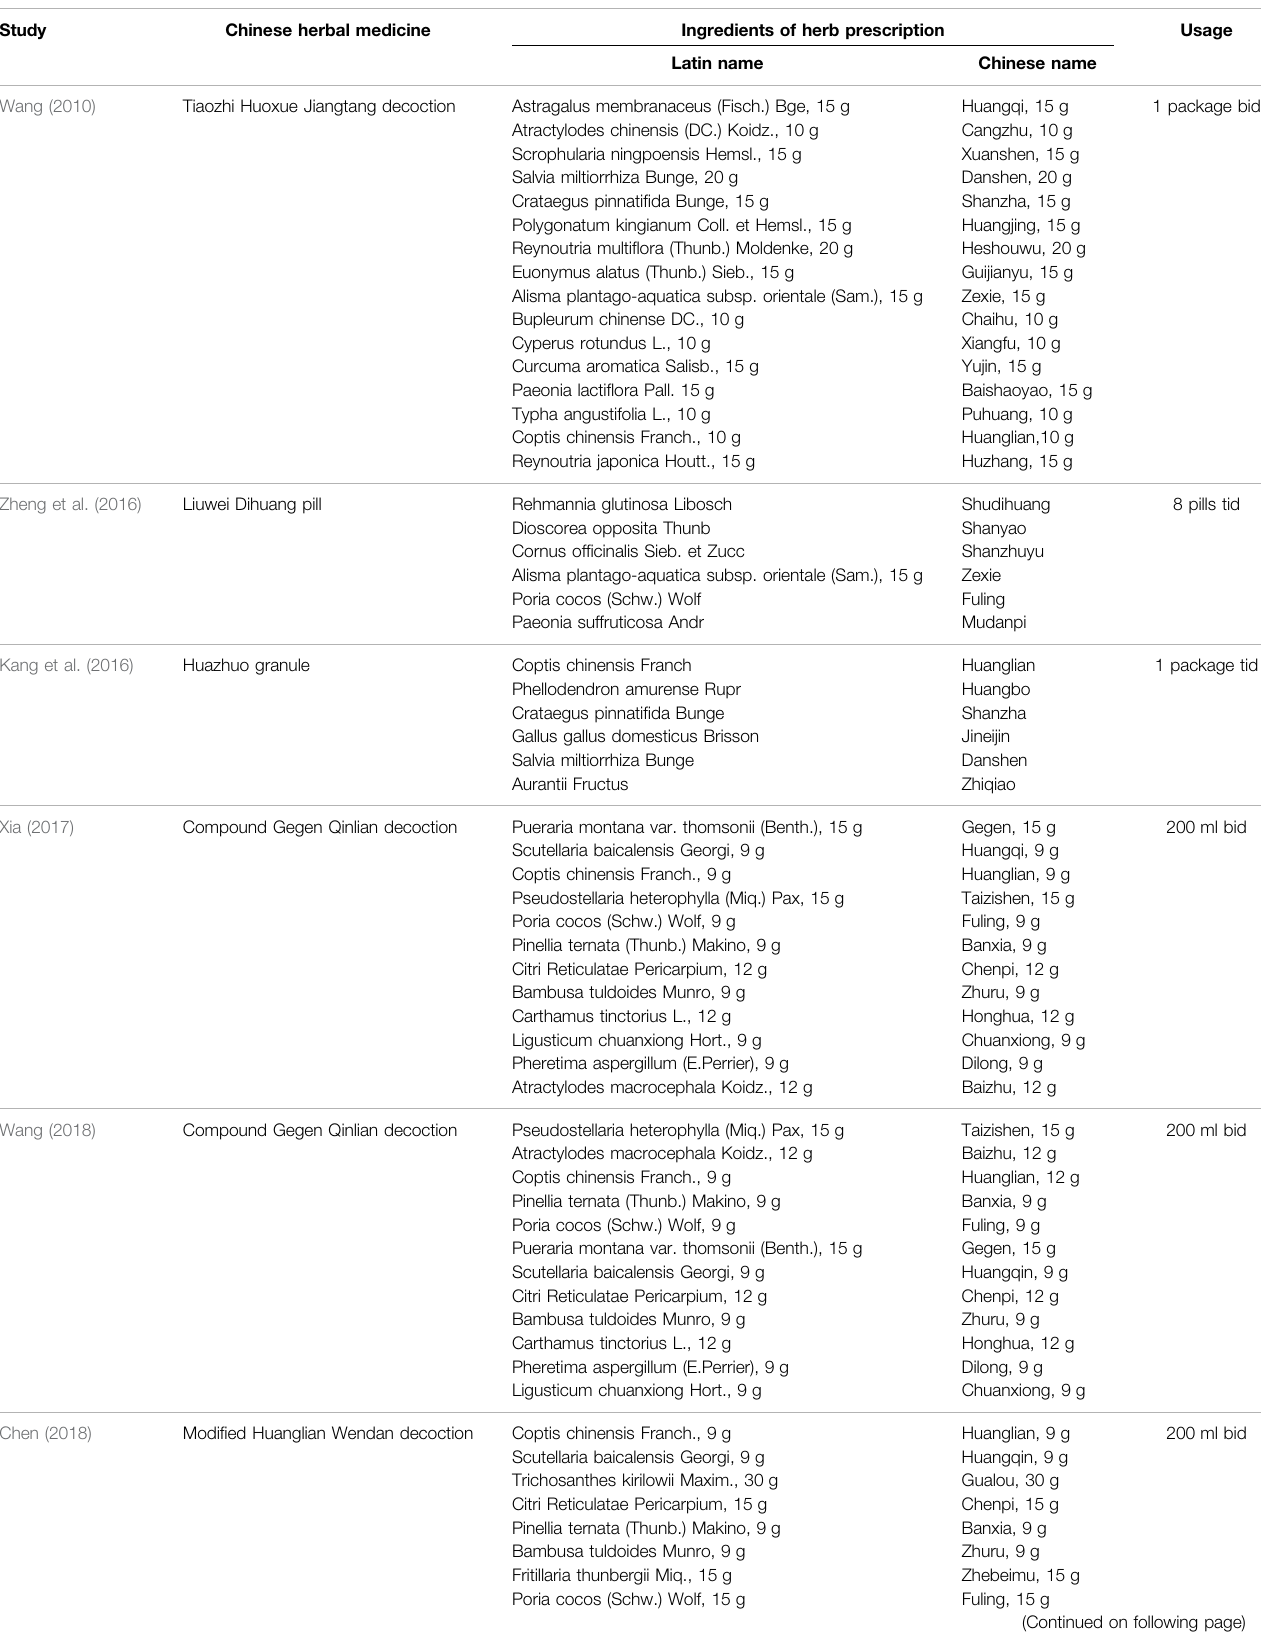
TABLE 2 | Detailed components of